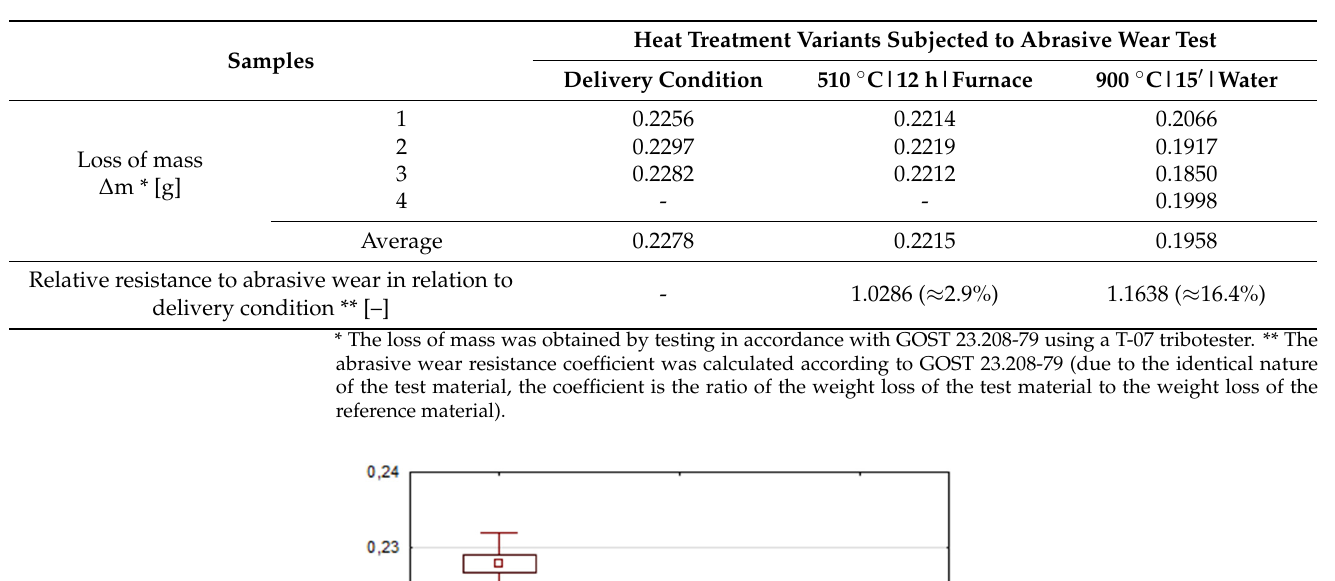
Table 3. Test results for abrasive wear resistance.